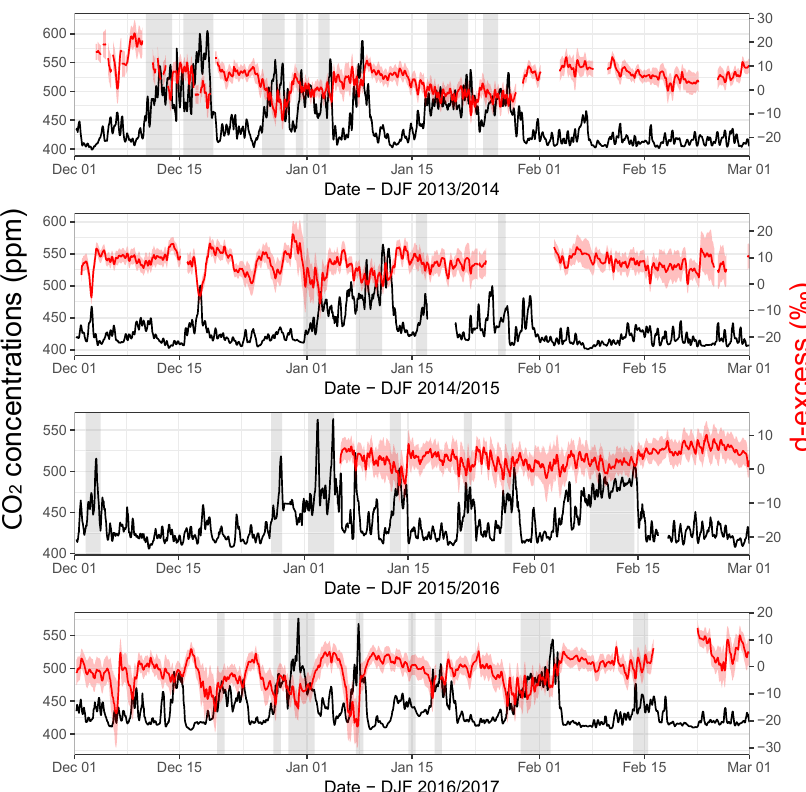
Figure 3. The 6h running-mean CO 2 concentrations (ppm, black line) and water vapor d-excess (‰ VSMOW, red line, 2 σ uncertainty shown in red shading) measured at the UOU for DJF 2013–2017. Persistent cold air pool events are denoted by gray rectangles. When the lower atmosphere is stable, CO 2 builds up in the boundary layer and d-excess tends to